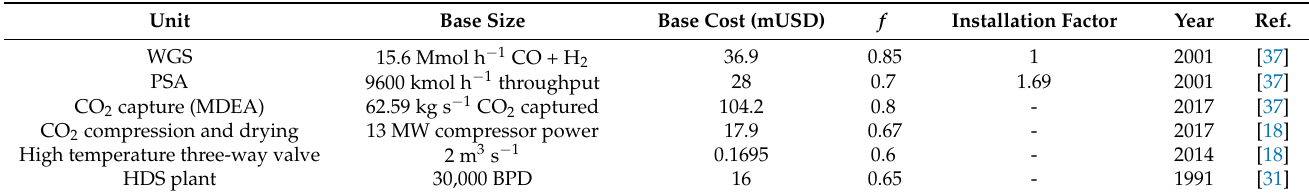
Table 3. Single point cost data for bare module